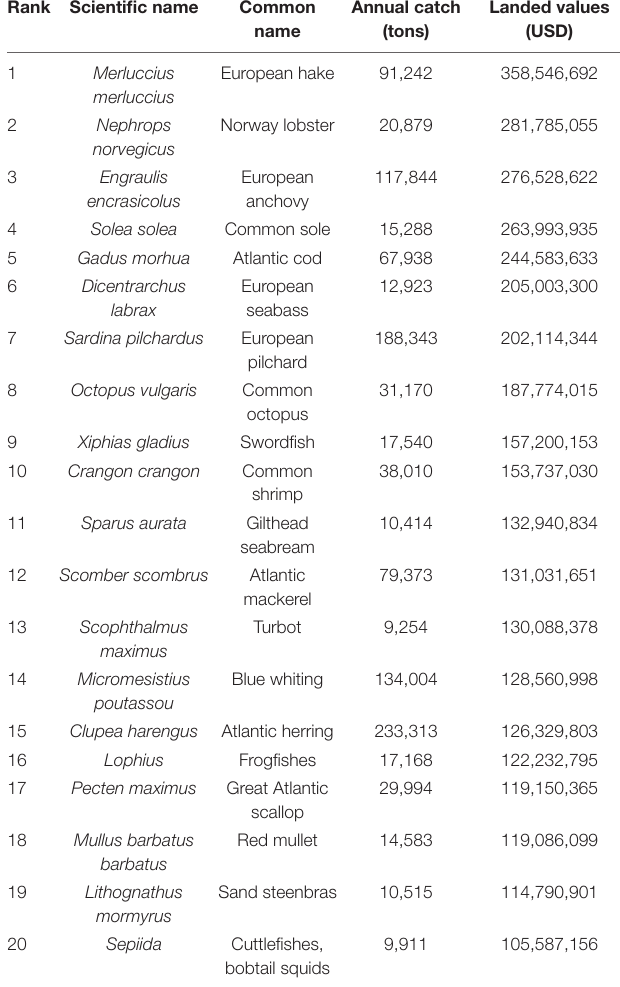
TABLE 1 | List of top 20 fish species by average annual catch (tons) and landed values (USD) taken from European waters by EU countries between 2007 and